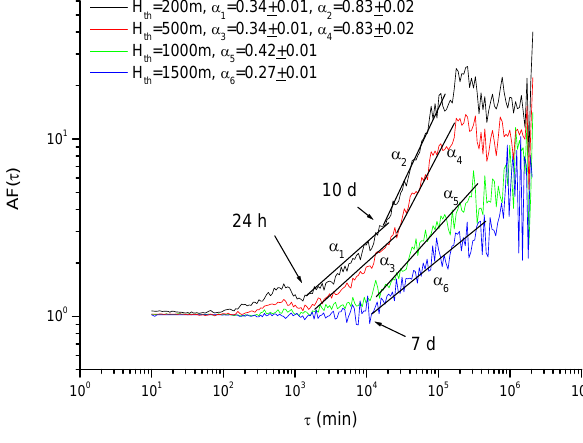
Fig. 4. AF for the whole data. Figure 4. AF for the whole data.